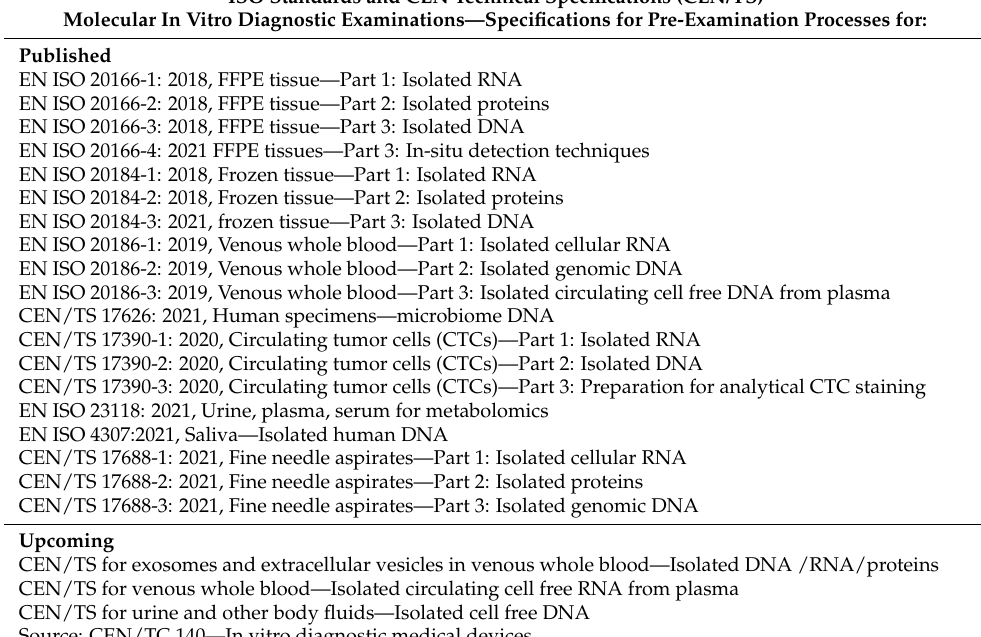
Table 2. Series of standards for sample pre-analytics as of March